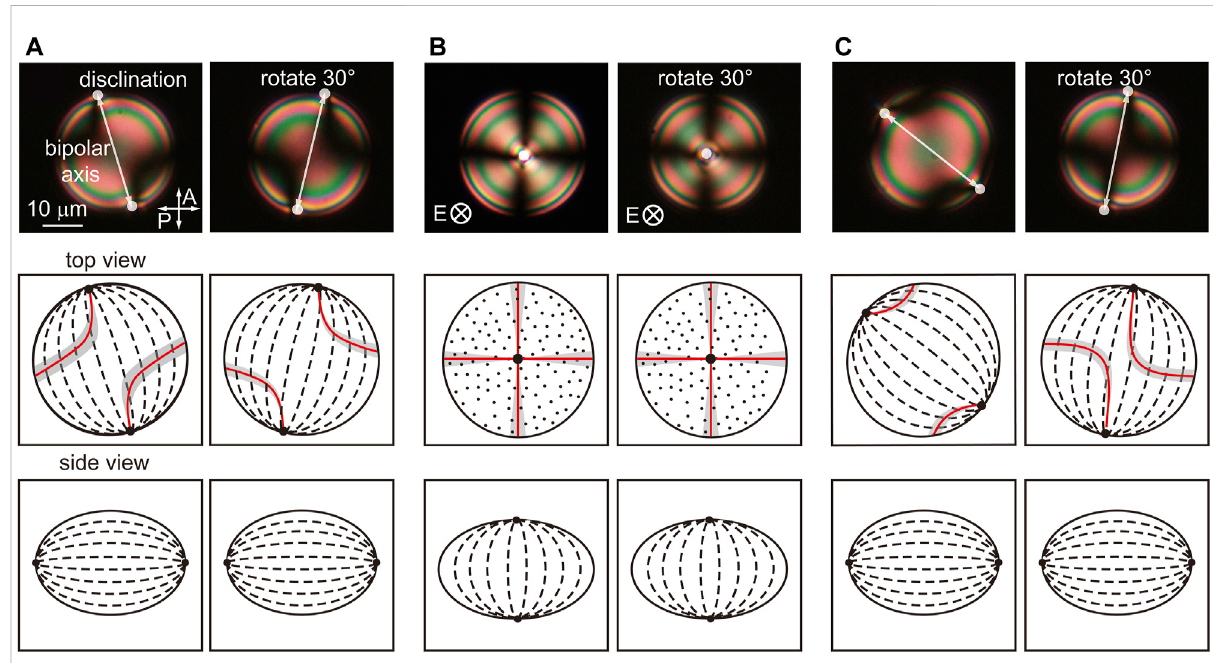
FIGURE 2 Electro-opticresponseofoblatenematicLCspheroids. (A) Opticaltextureofanoblate5CBnematicspheroidunderplanaranchoring,showing atypical bipolar director fi eldwith thebipolaraxis lying inthehorizontalplane.The top view shows the director fi eld atthemiddleplane and theside viewshowsthedirector fi eldatthesideplane. (B) Underathresholdelectric fi eld,LCmoleculesreorientalongtheE fi eldandthebipolaraxisswitches totheverticalposition,showingfourdarkbrushes.Becauseofthecircularsymmetry,theopticaltextureremainsunchangedwhenthesampleis rotated. The bipolar structure is trapped in the vertical con fi guration after removing the E fi eld. (C) Relaxation of the bipolar structure to the low- energy horizontal con fi guration is achieved when the sample is heated up to isotropic and then cooled down to